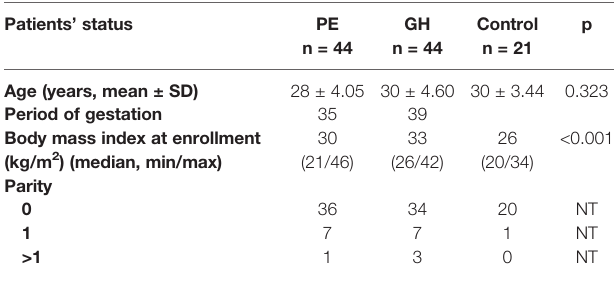
TABLE 1 | Patients ’